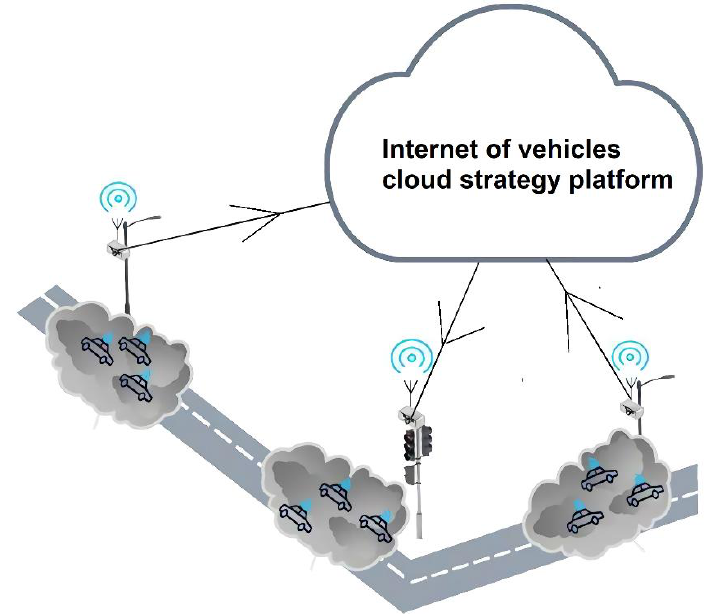
Figure 1. Smart streetlights in the Internet of Vehicles.